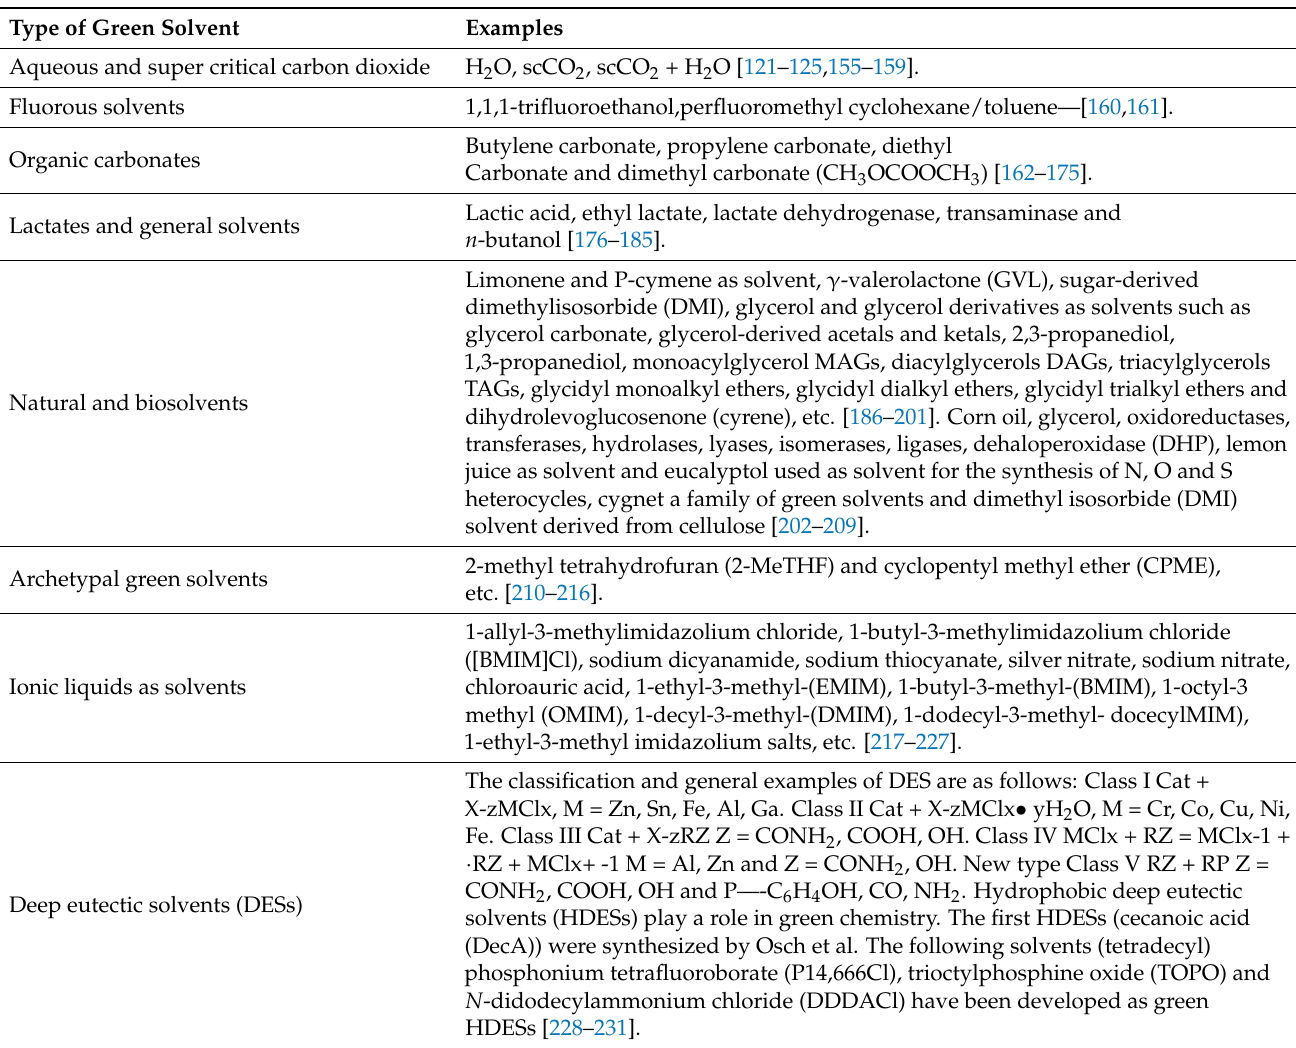
Table 2. Green solvents in organic